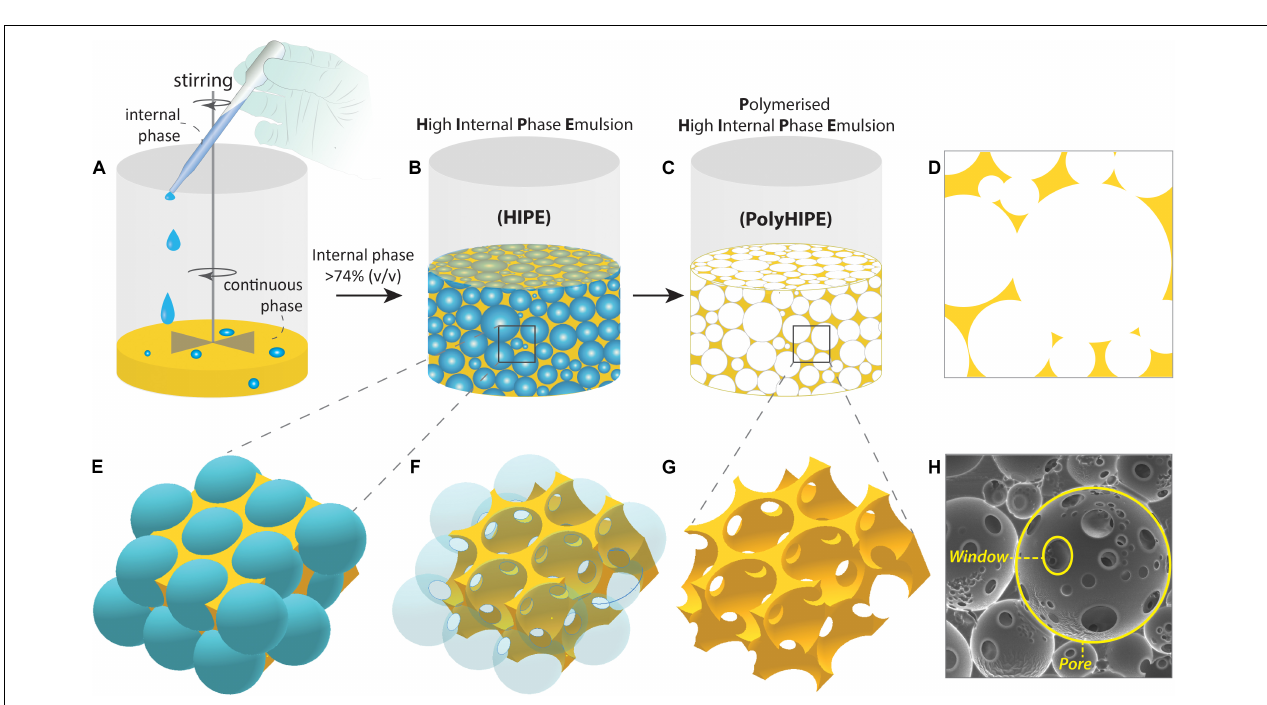
FIGURE 1 | Significance of the interconnectivity on scaffold design. (A) Scaffolds are 3D substrates that are implanted to the defect site to guide tissue regeneration. (B) Low interconnectivity limits cell infiltration due to blind (labelled with *) and inaccessible (labelled with #) pores, while higher interconnectivity provides enhanced permeability and cell penetration. (C) Scanning electron microscope image of the emulsion templated scaffold (polycaprolactone PolyHIPE) that shows tissue infiltration through the interconnected pores of the scaffold.